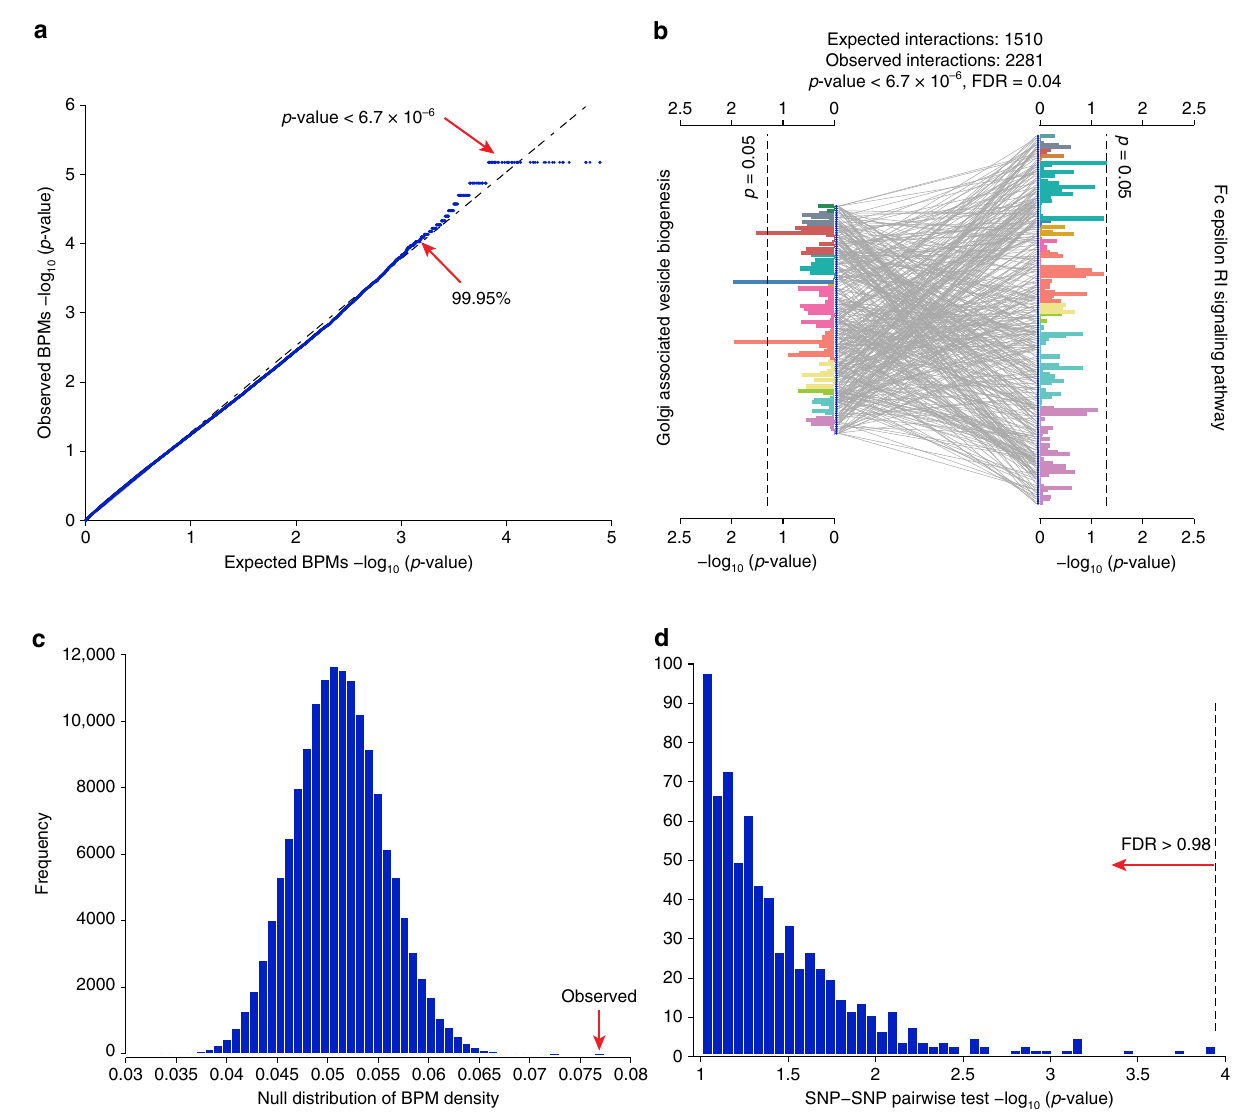
SNP−SNP pairwise test −log 10 ( p -value)Null distribution of BPM density Fig. 2 Signi fi cant pathway – pathway interactions discovered from the PD-NIA Parkinson ’ s disease cohort. a Quantile – quantile (QQ) plot comparing observed p -values (based on SNP-pathway membership permutations) for all possible pathway – pathway interactions between the 685 pathways to the expected, uniform distribution (log 10 scale). The horizontal line at 6.7 × 10 − 6 re fl ects the maximum resolution supported by 150,000 permutations. b Interaction between Golgi-associated vesicle biogenesis pathway (Reactome) and Fc ε RI signaling pathway (KEGG). Two sets of SNPs mapped to genes in these pathways are connected by gray lines that re fl ect SNP – SNP interactions above a lenient top-5% percentile cutoff. The two groups of horizontal bars (grouped and colored by chromosome) show the − log 10 p -values derived from a single-locus (univariate) test applied to each SNP individually (hypergeometric test), and the two dashed lines correspond to an uncorrected hypergeometric test p ≤ 0.05 cutoff, indicating that very few of the SNPs show marginal signi fi cant association before multiple hypothesis test correction. c Null distribution of the SNP – SNP interaction density between the Golgi- associated vesicle biogenesis pathway and Fc ε RI signaling pathway described in b based on 150,000 SNP permutations. The observed density for the Golgi-associated vesicle biogenesis and Fc ε RI signaling interaction is indicated by the red arrow and was not exceeded by any of the random instances ( p perm < 6.7 × 10 − 6 ). d Distribution of p -values from individual tests for pairwise SNP – SNP interactions for SNP pairs supporting the pathway – pathway interaction, as measured by an additive disease model ( − log 10 p -value). None of the SNP pairs are signi fi cant after multiple hypothesis correction (dashed line at the most signi fi cant SNP – SNP pair corresponds to FDR =